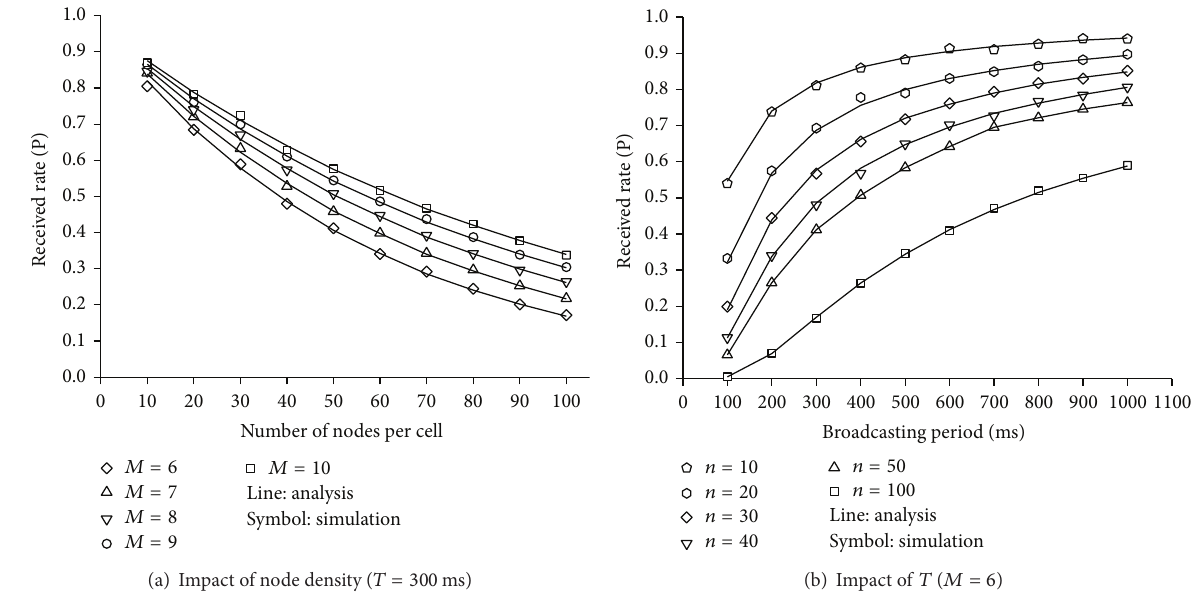
Figure 12: Probability of successfully receiving an NMU message.